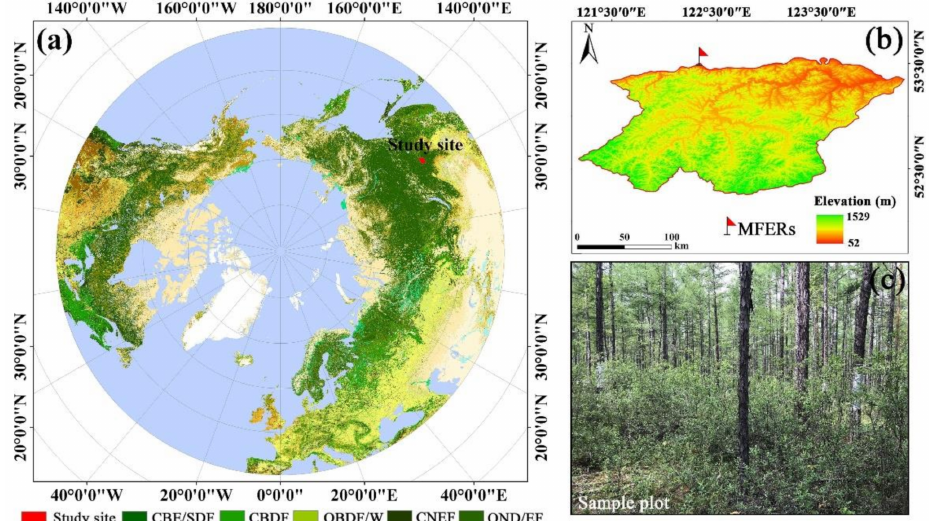
Figure 1. ( a ) The region north of 40 ◦ N (Globcover2009: http://due.esrin.esa.int/page_globcover.php, accessed on 2 January 2022). ( b ) The DEM of study site; ( c ) Sample plot. Note that the CBE/SDF, CBDF,